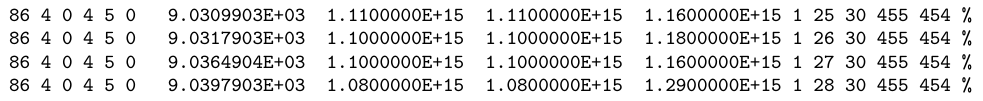
Figure 4. Content of file d 454 t 086 of the XSTAR database listing the radiative and Auger widths (data type dt = 86 and rate type rt = 4) of Mg-like Zn XIX ( ion = 454). Table A1 in Appendix B tabulates the number of levels for each ionic species ( Z ; N )